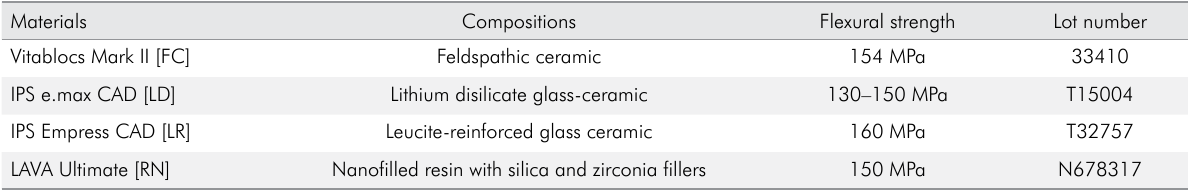
Table 1. Compositions and flexural strength of CAD/CAM materials